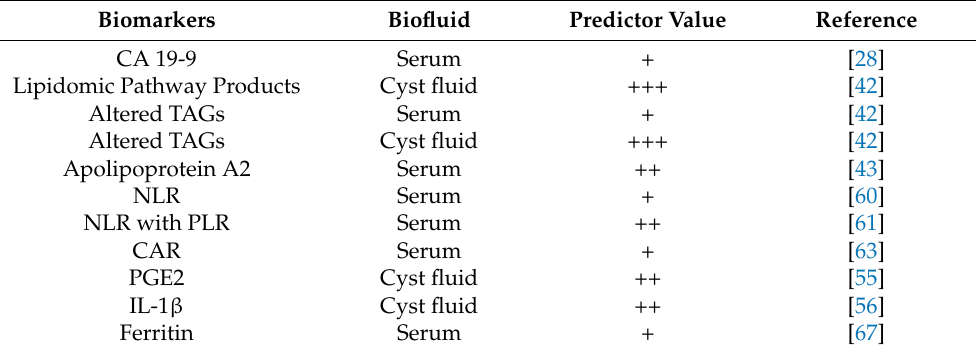
Table 1. Utility of reviewed potential biomarkers in distinguishing grades of